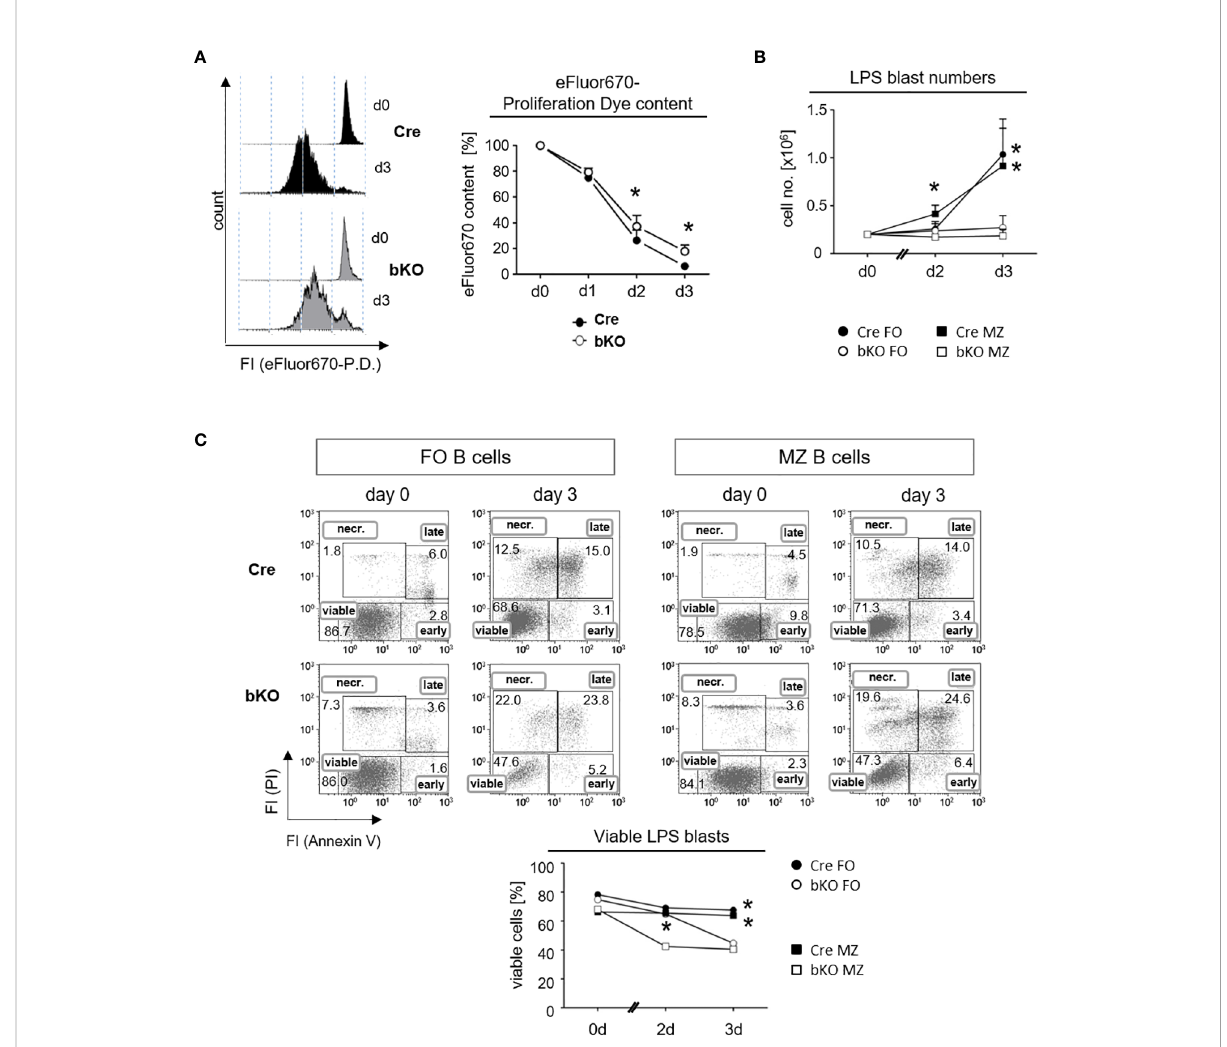
FIGURE 4 DGCR8-de fi ciency affects the proliferation and viability of follicular and marginal zone B cells in vitro. (A) Naive splenic B cells were isolated from Cre control and DGCR8-bKO mice by magnetic cell sorting (EasySep © ) and analyzed for lipopolysaccharide (LPS)-induced proliferation in vitro . Cells were stained with the proliferation dye (P. D.) eFluor670 right after isolation, and the content of the dye was measured for three days using fl ow cytometry. The representative fi gure shows eFluor670 content (day 0 and day 3). The graph depicts changes in eFluor670 fl uorescence intensity of Cre and DGCR8-bKO cells normalized to the basic value determined on day 0. Points represent the mean from n=4 mice per genotype. (B) Fluorescence-based fl ow cytometry-sorted splenic MZ B cells (CD19 + CD23 low CD21 + ) and FO B cells (CD19 + CD23 + CD21 low ) from Cre control and DGCR8-bKO mice were stimulated in vitro with LPS. Cell numbers were determined using fl ow count beads. Points represent the mean from n=3 mice per genotype. (C) Cell viability in the samples described in (B) was analyzed at different time points by fl ow cytometry with propidium iodide (PI) and AnnexinV. AnnexinV- and PI-negative cells were de fi ned as viable. Mann-Whitney test was used for statistical analysis. * p<0.05;